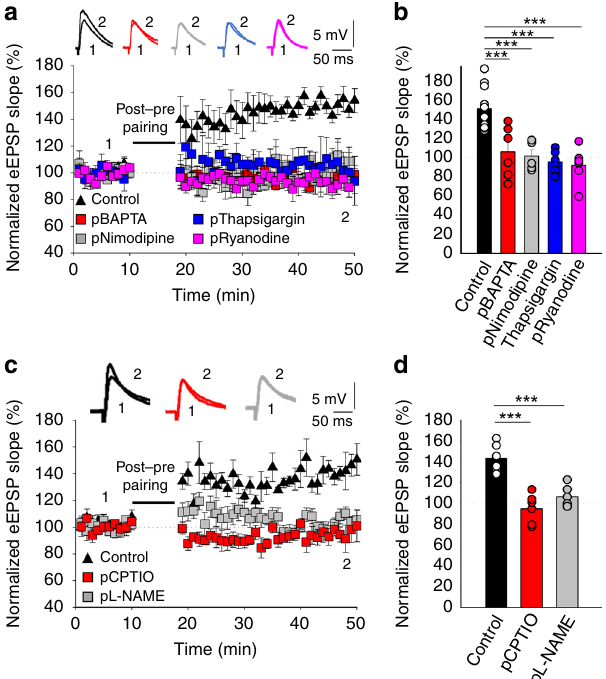
Fig. 4 t-LTP requires postsynaptic calcium and NO. a t-LTP is prevented by loading BAPTA (20 m M ) into the postsynaptic recording pipette. into the postsynaptic neuron via the patch pipette prevented t-LTP induction. The EPSP slopes shown were monitored in control slices (black triangles, n = 11) and in slices treated with BAPTA (red squares, n = 6), nimodipine (gray squares, n = 6), thapsigargin (blue squares, n = 6) and ryanodine (pink squares, n = 6). The traces show the EPSP before (1) and 30 min after (2) pairing. b Summary of the results. c Time course of the effect of post-before-pre pairing in control conditions (black triangles, n = 6) and with cPTIO (100 μ M , red squares, n = 6) and L-NAME (100 µ M , gray squares, n = 6) loaded into the postsynaptic neuron. Insets: the traces show the EPSPs before (1) and 30 min after pairing (2). d Summary of the results. *** p < 0.001, one-way ANOVA + Holm – Sidak. The error bars represent the S.E.M. Source data are provided as a Source Data fi